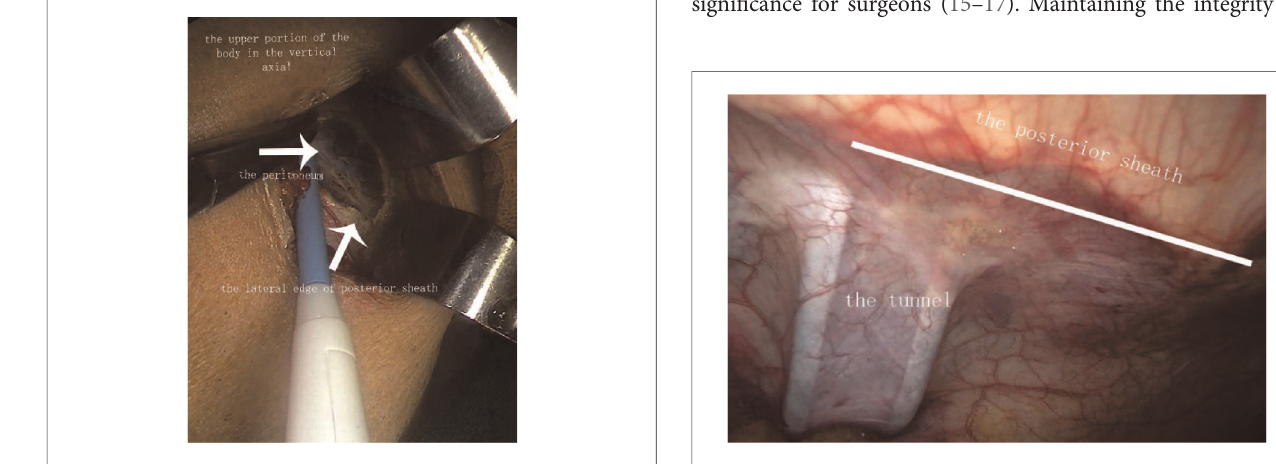
FIGURE 2 | Open approach. FIGURE 3 | Extraperitoneal tunnel.